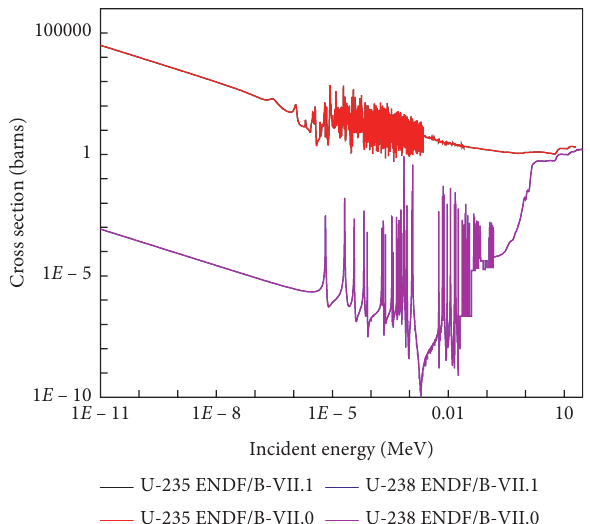
Figure 9: 235 U and 238 U fission cross sections of ENDF/B-VII.0 and ENDF/B-VII.1.